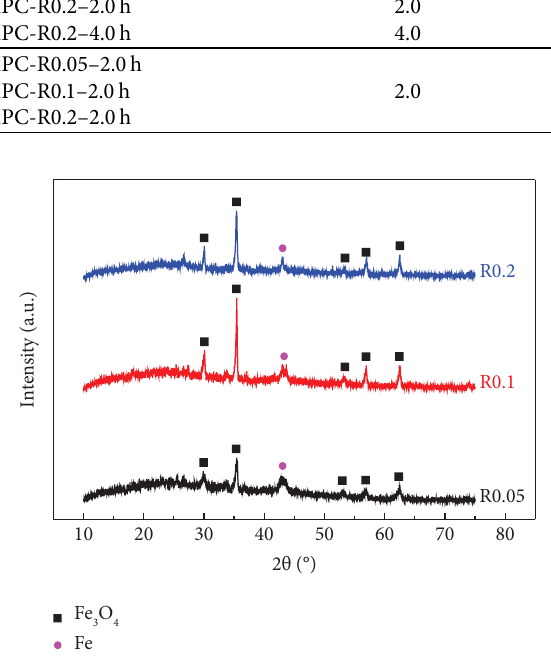
Figure 4: XRD patterns of MPC-Rx-2.0h samples prepared from diferent FeCl 3 /NF mass ratios ( x